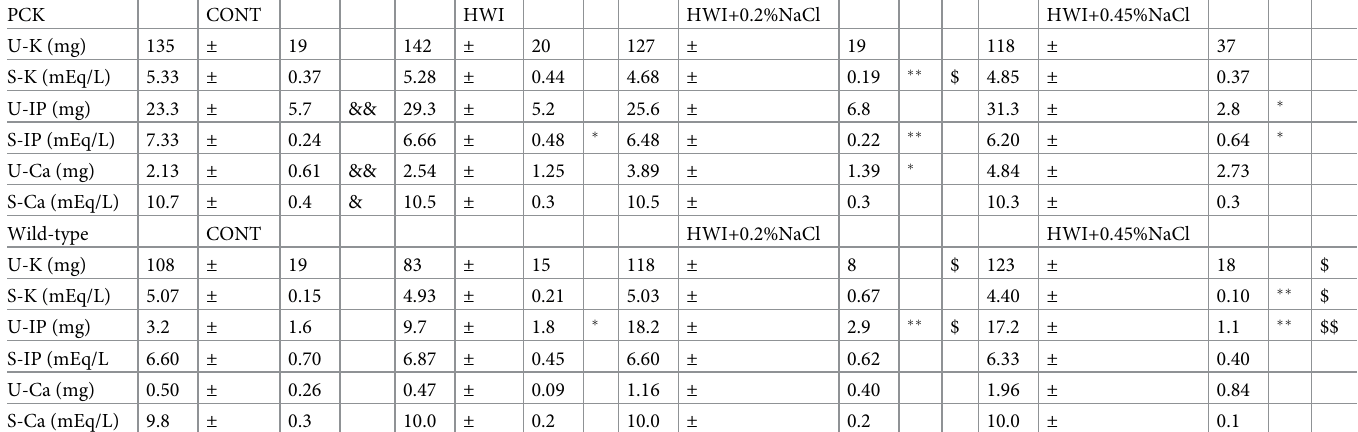
Table 1. Effect of HWI and NaCl overload on urine excretion and blood concentrations of electrolytes. PCK CONT HWI